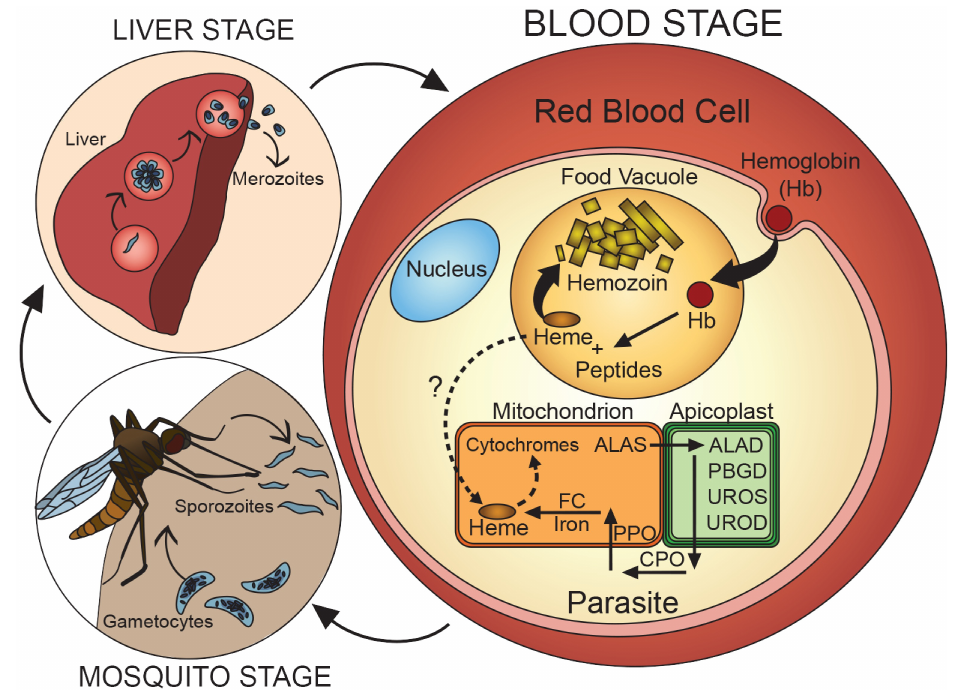
Fig 1. Plasmodium parasitesrequirehemeasa metabolic cofactorthroughout theirlife cycle. Plasmodium enzymeabbreviationsareconsistent withthoseusedatthe Plasmodium Genomics Resource(PlasmoDB.org). Abbreviations:ALAD, aminolevulinicaciddehydratase;ALAS,aminolevulinicacidsynthase; CPO,coproporphy- rinogenoxidase;FC, ferrochelatase;PBGD,porphobilinogendeaminase;PPO, protoporphyrinogenoxidase; UROD,uroporphyrinogendecarboxylase;UROS,uroporphyrinogensynthase.